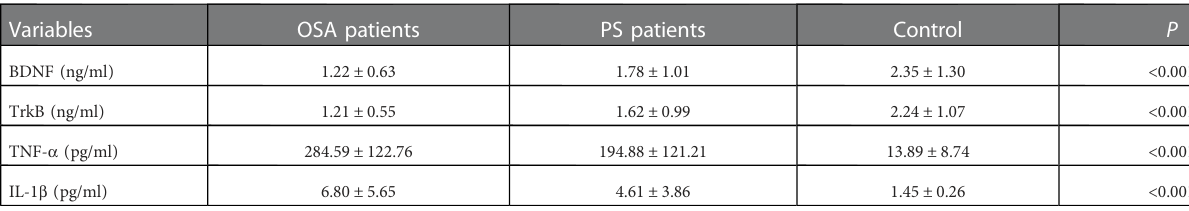
TABLE 4 Comparisons of BDNF, trkB, IL-1 β and TNF- α among three